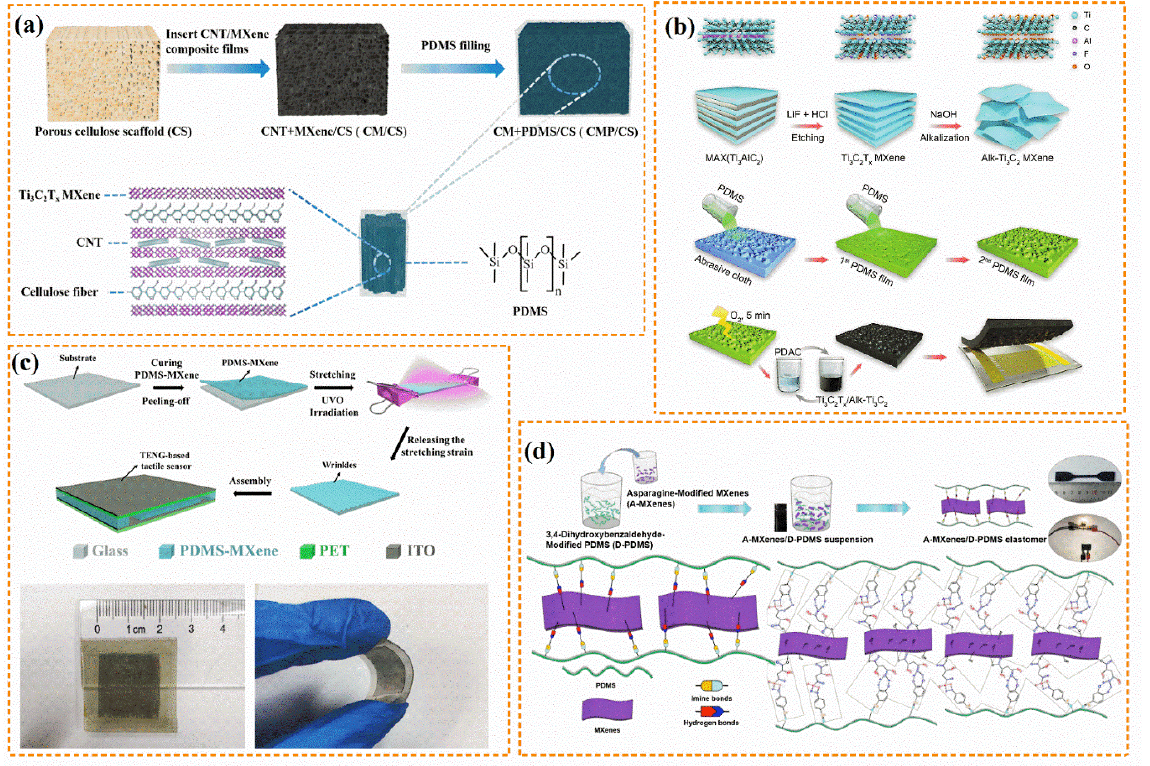
Figure 7. ( a ) Schematic of synthetic procedure for multifunctional elastic CNT/Ti 3 C 2 T x /PDMS/CS composites. Compressibility of composites for 1000 cycles at 30% strain (Reprinted with permission from Ref. [68]. Copyright 2021, copyright Elsevier). ( b ) Schematic of fabrication of Alk-Ti 3 C 2 and PDMS films with positive structures and flexible pressure sensors (Reprinted with permission from Ref. [29]. Copyright 2021, copyright Wiley-VCH). ( c ) Schematic of fabrication and real images of triboelectric tactile sensor based on wrinkled PDMS/MXene composite films (Reprinted with per- mission from Ref. [70]. Copyright 2020, copyright Elsevier). ( d ) Main preparation steps of A- MXene/D-PDMS elastomer and interaction between A-MXene and D-PDMS (Reprinted with per- mission from Ref. [71]. Copyright 2020, copyright ACS). (PDAC: poly(diallyl dimethylammonium chloride); PET: polyethylene terephthalate; ITO: indium tin oxide). Figure 7b,c show the preparations of the different flexible sensors with rough PDMS substrates. The wrinkles or convex structures of substrates help to increase the sensitivi- ties and signal intensities of flexible sensors. Xiang et al. [29] produced a flexible piezore- sistive sensor with NaOH-alkalized 3D crinkled Ti 3 C 2 MXene (Alk-Ti 3 C 2 ) conductive ma- terial and rough PDMS substrate. The flexible sensor was assembled with convex-struc- tured PDMS coated with Alk-Ti 3 C 2 and poly(diallyl dimethylammonium chloride) using the layer-by-layer method. In addition to PDMS with microstructures, crinkled Alk-Ti 3 C 2 can further improve the sensitivity of the sensor. A flexible piezoresistive sensor achieved an ultrawide pressure range of 0–800 kPa, low detection limit of 17 Pa, ultrahigh sensitiv- ity of 95.26–1104.38 kPa − 1 , fast response time of 100 ms, and excellent cycle stability of 3000 cycles at 300 kPa. This sensor is suitable for applications requiring multiple pressure meas- urements, such as wrist pulse, vocal-cord vibration, and weight measurements. Cai et al. [70] designed a flexible ultrasensitive triboelectric tactile sensor based on wrinkled PDMS/MXene composite films. The films were prepared by stretching and ultraviolet ozone irradiation treatment because a triboelectric nanogenerator (TENG) consists of a wrinkled PDMS/MXene film and two polyethylene terephthalate films. The triboelectric tactile sensor achieved ultrahigh sensitivities of 0.18 and 0.06 V·Pa − 1 in ranges of 10–80 Pa and 80–800 Pa, respectively. The sensor can be applied to monitor complex human